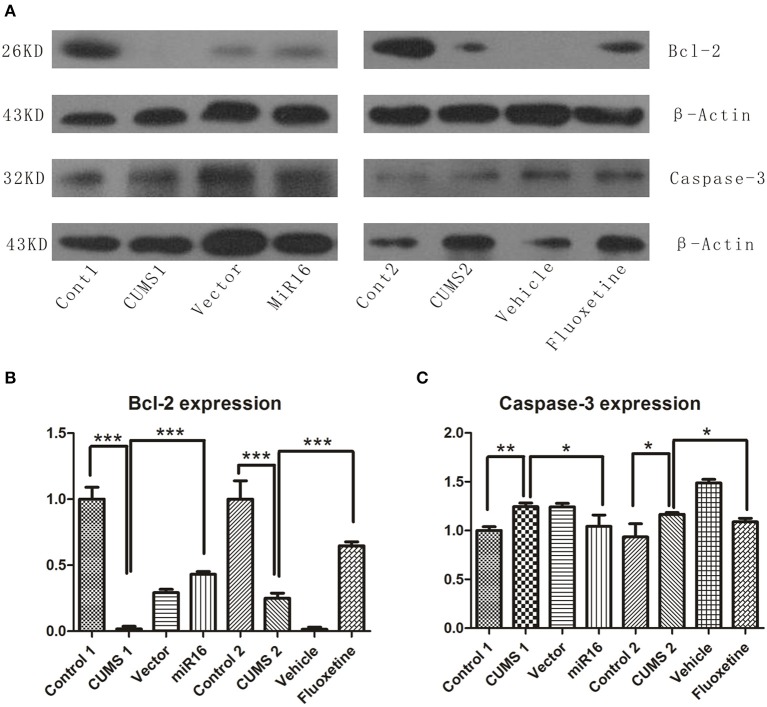
Western blot was conducted to detect the expression level of Bcl-2 and Caspase-3 among each group. Western blot presents an increasing tendency in Bcl-2 in miR-16 and Fluoxetine treatment groups, but a decrease in CUMS groups, while an opposite change appears in Caspase-3 expression. (A) Compared with Control groups, the image shows a significant decrease in Bcl-2 expression in CUMS groups, but increasing Caspase-3 expression, and the miR-16 and Fluoxetine groups attenuate the change. The mean change in Bcl-2 (B) and Caspase-3 (C) are showed in the histogram. Values are the means ± SEMs. *P < 0.05; **P < 0.001; ***P < 0.0001.